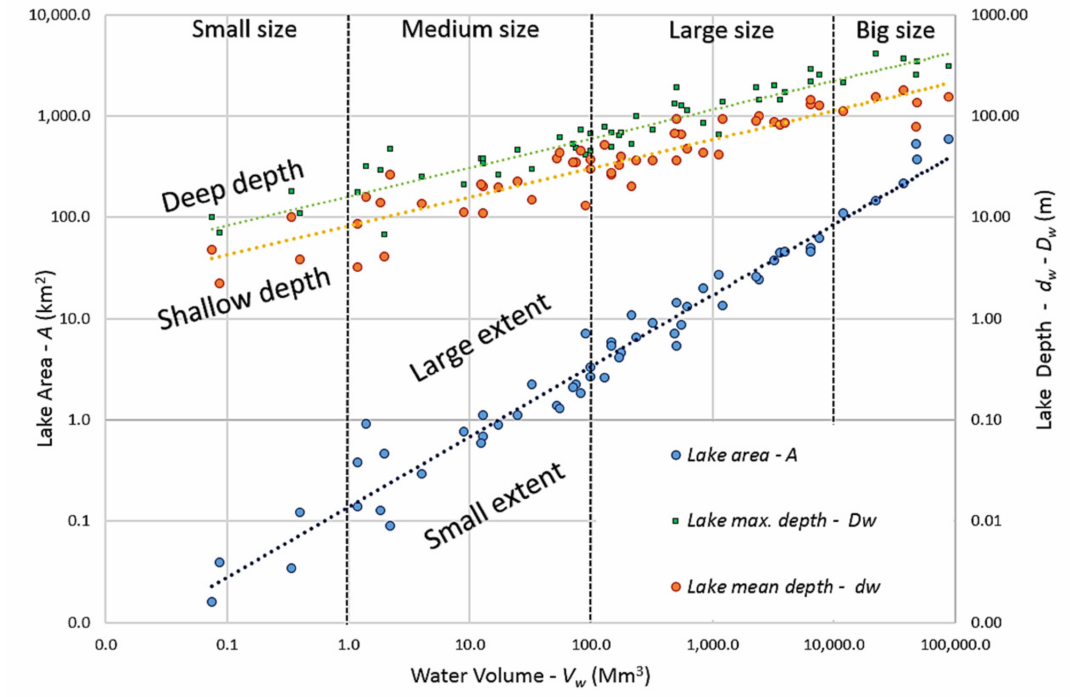
Figure 2. Classification of 56 alpine lakes based on water volume, the lake area, and mean and maximum lake depths: dotted blue line is V w against A ; dotted orange line is V w against d w ; the dotted green line is V w against D w. Trendlines enable a qualitative description of the lakes in terms of their extent and depths relative to water volume. Axes are logarithmic (base